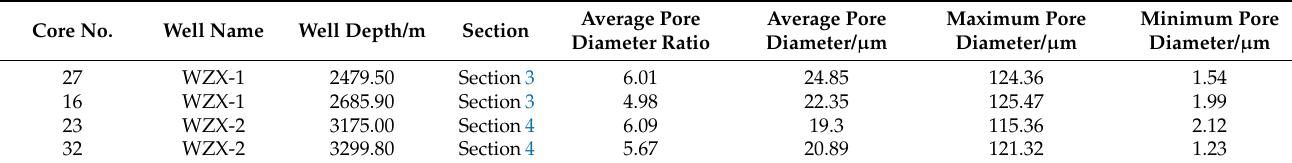
Table 2. Analysis of pore throat size